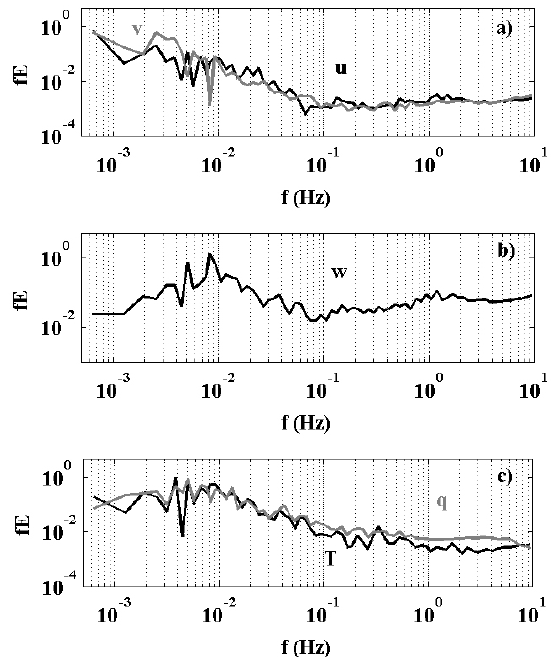
Figure 6. As per Figure 4 but relative to the time series shown in Figure 3.